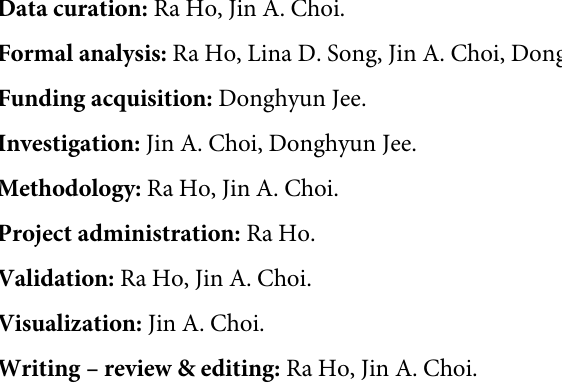
S4 Fig. Two-way sensitivity analysis simultaneously varying the cost of mild and moderate age-related macular degeneration. S1 Table. Detailed breakdown of